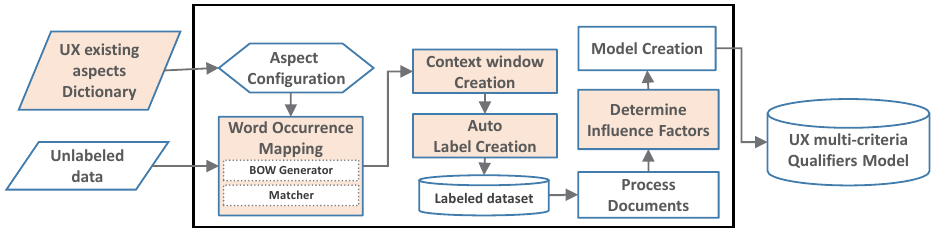
Figure 3. A UX multi-criteria qualifiers model